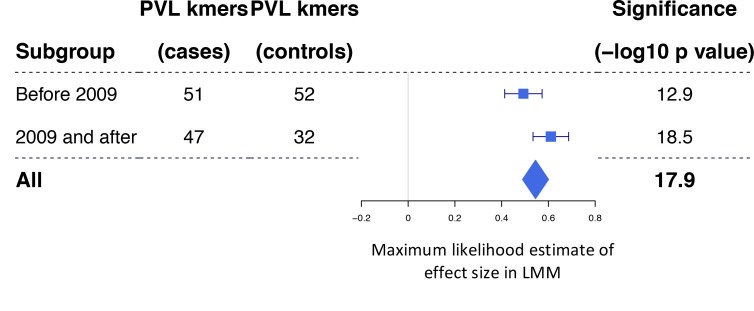
Significant association between case/control status and the presence of kmers mapping to PVL was consistent across early and late subsets.Results from repeat kmer GWAS using early and late sub-groups of cases and controls, as well as results from original GWAS of the entire group. We report the presence of kmers mapping across the PVL locus in each subset. Forest plot showing the effect sizes (box) with 95% CI (whiskers) determined by LMM for kmers mapping to PVL kmer in each subset, and in the complete study (diamond centred on effect size extending across 95% CI). The statistical significance of association with case/control status after controlling for population structure is shown for each subset and the complete study.